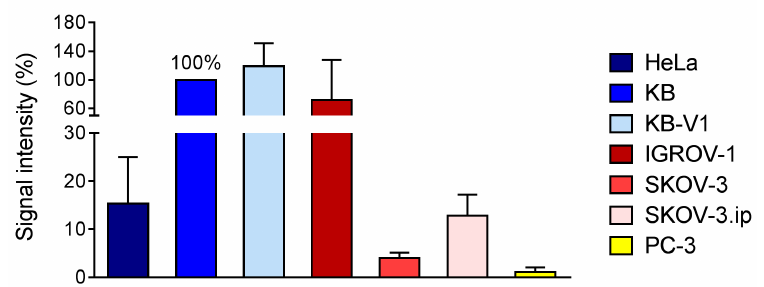
Figure 4. Quantification of in vitro autoradiography results in tumor tissues. Values obtained for KB cell line were set as 100% and compared with the other tissues.